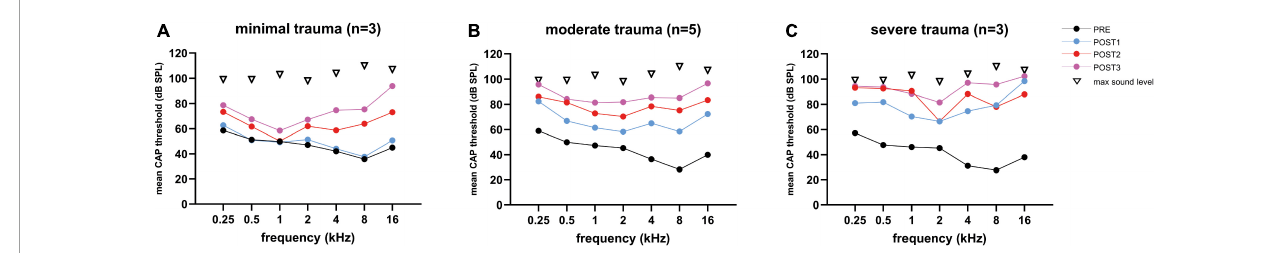
FIGURE7 The mean CAP thresholds of all three trauma groups are shown across all tested frequencies (0.25–16 kHz), and the 4 stages. The PRE values were comparable between the three groups. Threshold shifts in all three groups were observed across all frequencies, and increased with every POST stage, except for the minimal trauma group (A) , in which barely any threshold shift was observed across all tested frequencies at POST1. The ranges among animals vary considerably between frequencies: (A) for minimal trauma 1 to 27 dB for low frequencies (0.25 to 2 kHz), and 4 to 52 dB for high frequencies (4 to 16 kHz); (B) for moderate trauma 8 to 50 dB for low frequencies, and 8 to 70 dB for high frequencies; (C) for severe trauma 5 to 30 dB for low frequencies, and 4 to 33 dB for high